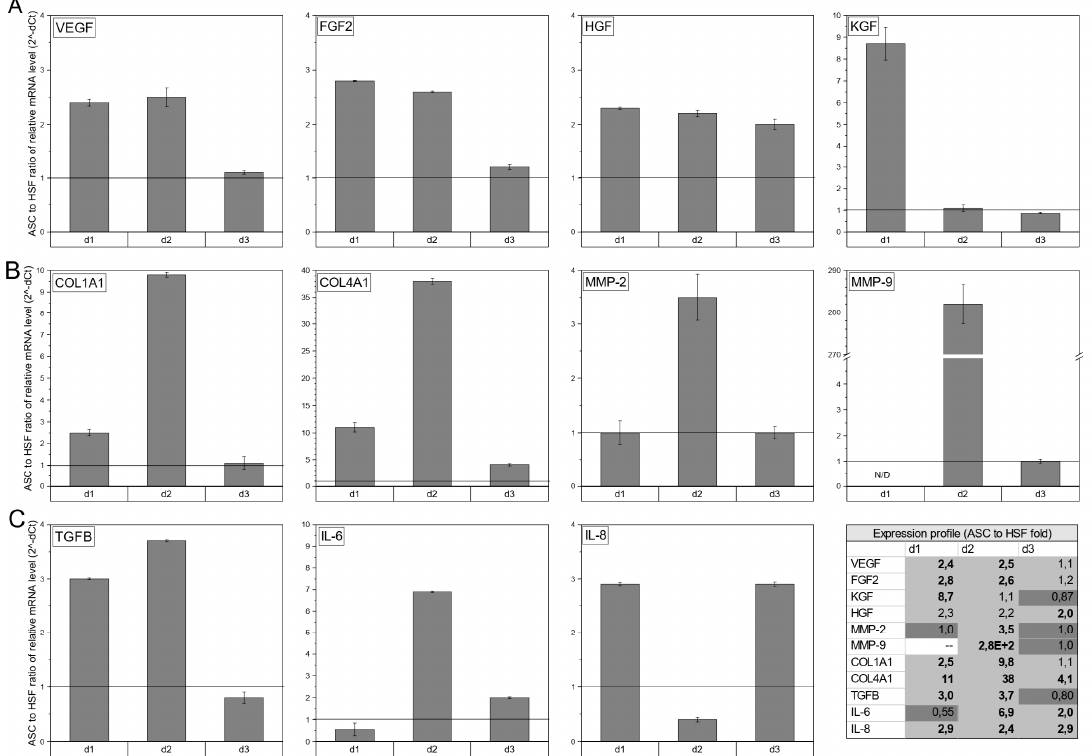
Figure 2. The expression of healing-promoting cytokines (VEGF, FGF2, HGF, and KGF) ( A ), selected tissue-remodeling-associated factors (Collagen I and IV, metalloproteinase (MMP)-2, and MMP-9) ( B ), and immunomodulatory cytokines (TGF β , IL-6, and IL-8) ( C ). ASCs in compared to human skin fibroblasts (HSFs), both cultured for 3 weeks on Integra ® DRT matrix. HSFs were harvested from the same donor as ASCs and were used as reference. The transcription profiles of the selected genes are presented as a fold change of relative mRNA levels in ASCs to relative mRNA level in HSFs. The black horizontal line is placed at fold change 1.0. Legend: d1, donor1; d2, donor 2; d3, donor 3.